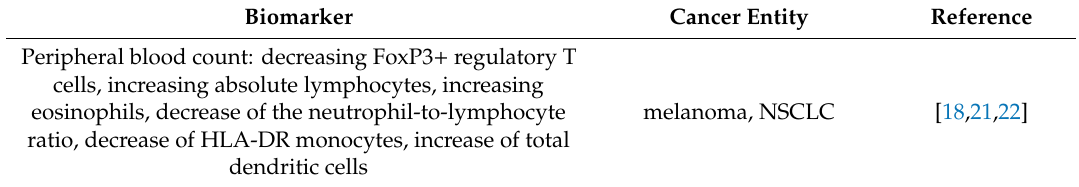
Table 2. Treatment response monitoring (predictive) biomarkers of checkpoint inhibitor therapy.